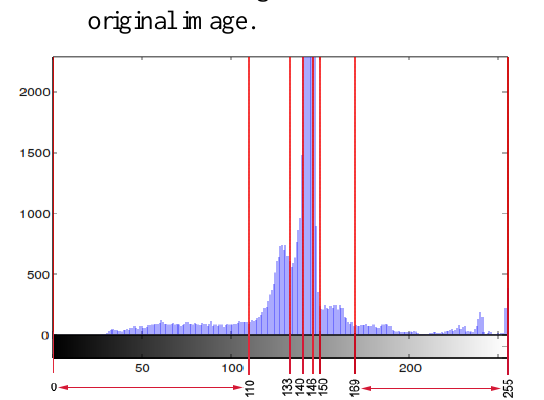
Figure 4. Histogram divisions and the obtained intervals by initial implantation of algorithm1.